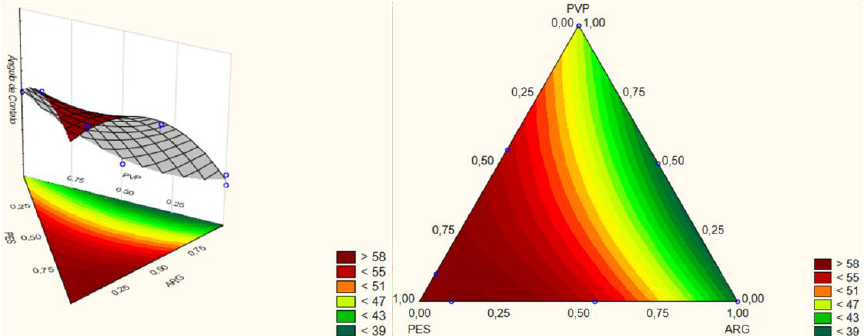
Figure 9. Response surface graph and contour graph according to the quadratic model for the contact angle.